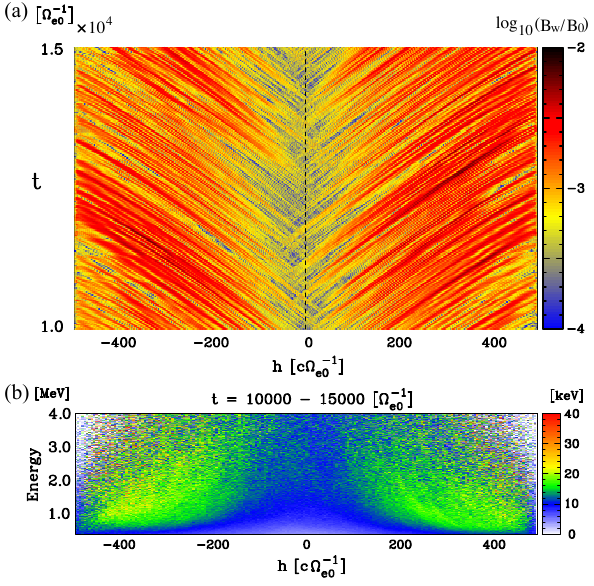
Fig. 3. The top panel shows the spatial profile of the ampli- tude of the transverse wave magnetic field and its time evolution. Modes with longer wavelengths than chorus emissions are elimi- nated. Wave packets of whistler-mode waves are successively gen- erated near the magnetic equator, their amplitudes increasing as they propagate into both hemispheres. The bottom panel shows the spa- tial distribution of the energy increase of accelerated electrons, as a function of kinetic energy and position at t = 10000 (cid:127) − 1 . The ef- e 0 ficiency of the acceleration depends on both the wave amplitude of the chorus emissions and the variation of the resonant velocity V R . The variation of V R is due to both the spatial inhomogeneity of the background magnetic field and the wave frequency of the chorus